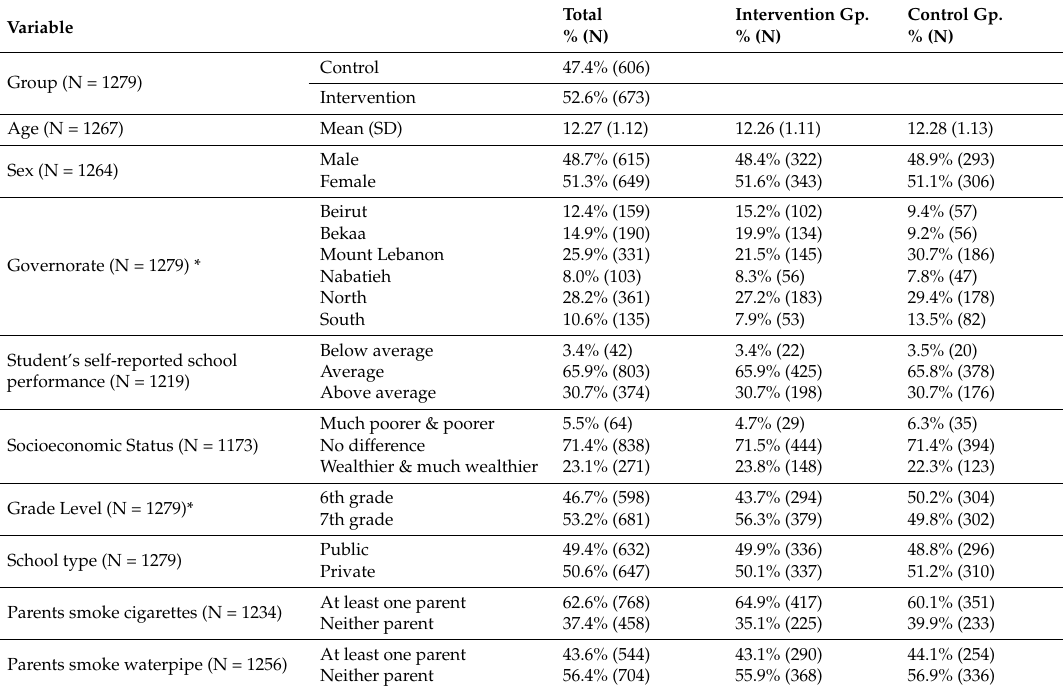
Table 1. Descriptive Socio-demographic Characteristics of the participants overall, and in intervention and control